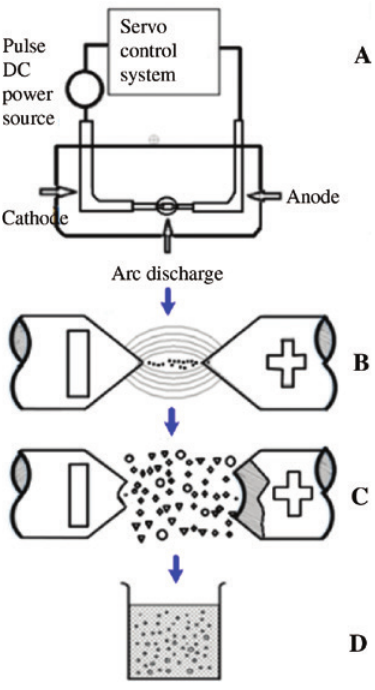
Figure 4: The system construction of SADM and process of produc- ing nanoparticles. (A) SADM system configuration. (B) Ionization